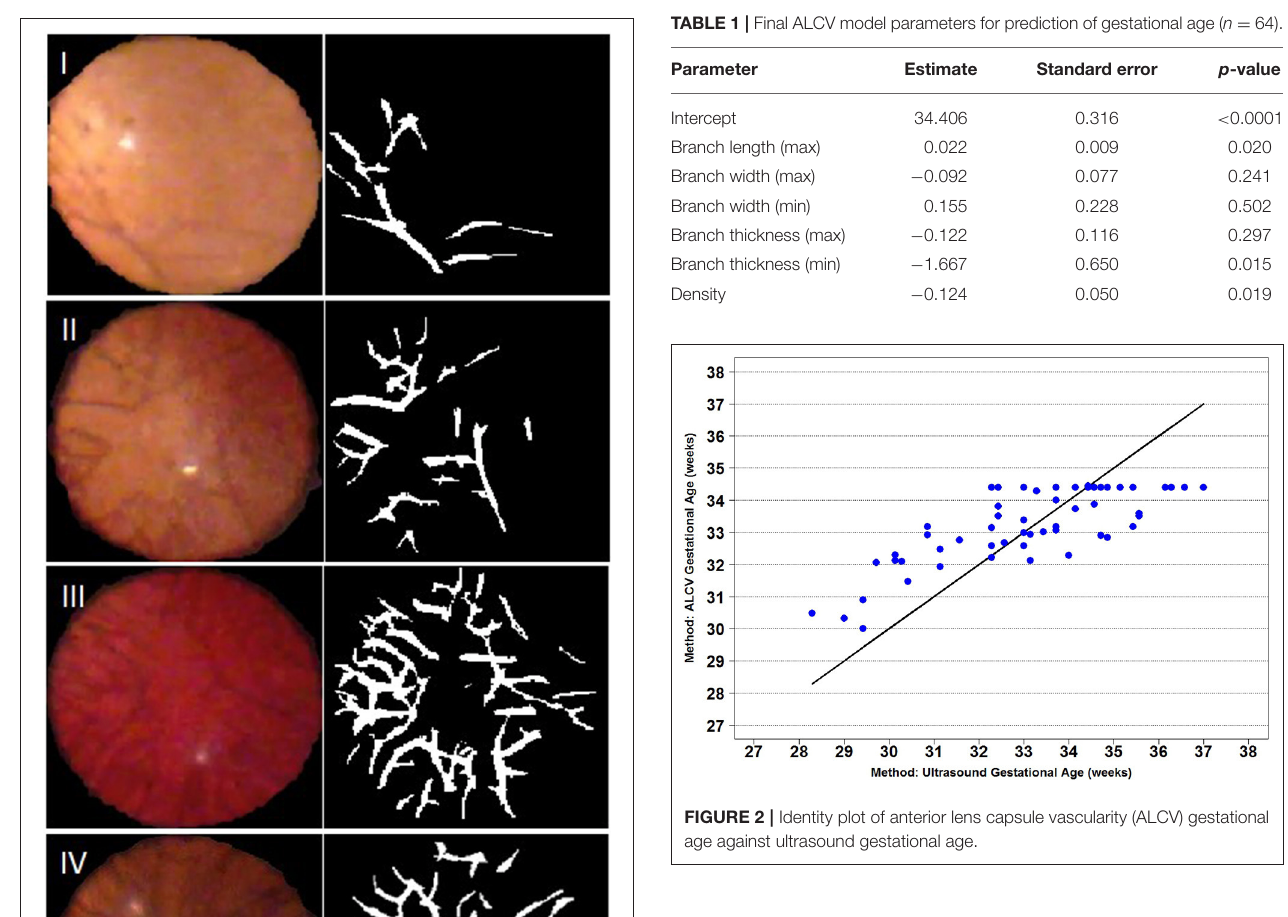
Multicollinearity assessment (11), Akaike Information Criterion, Bayesian Information Criterion, and agreement between Bland- Altman, mean-squared deviation, and coverage